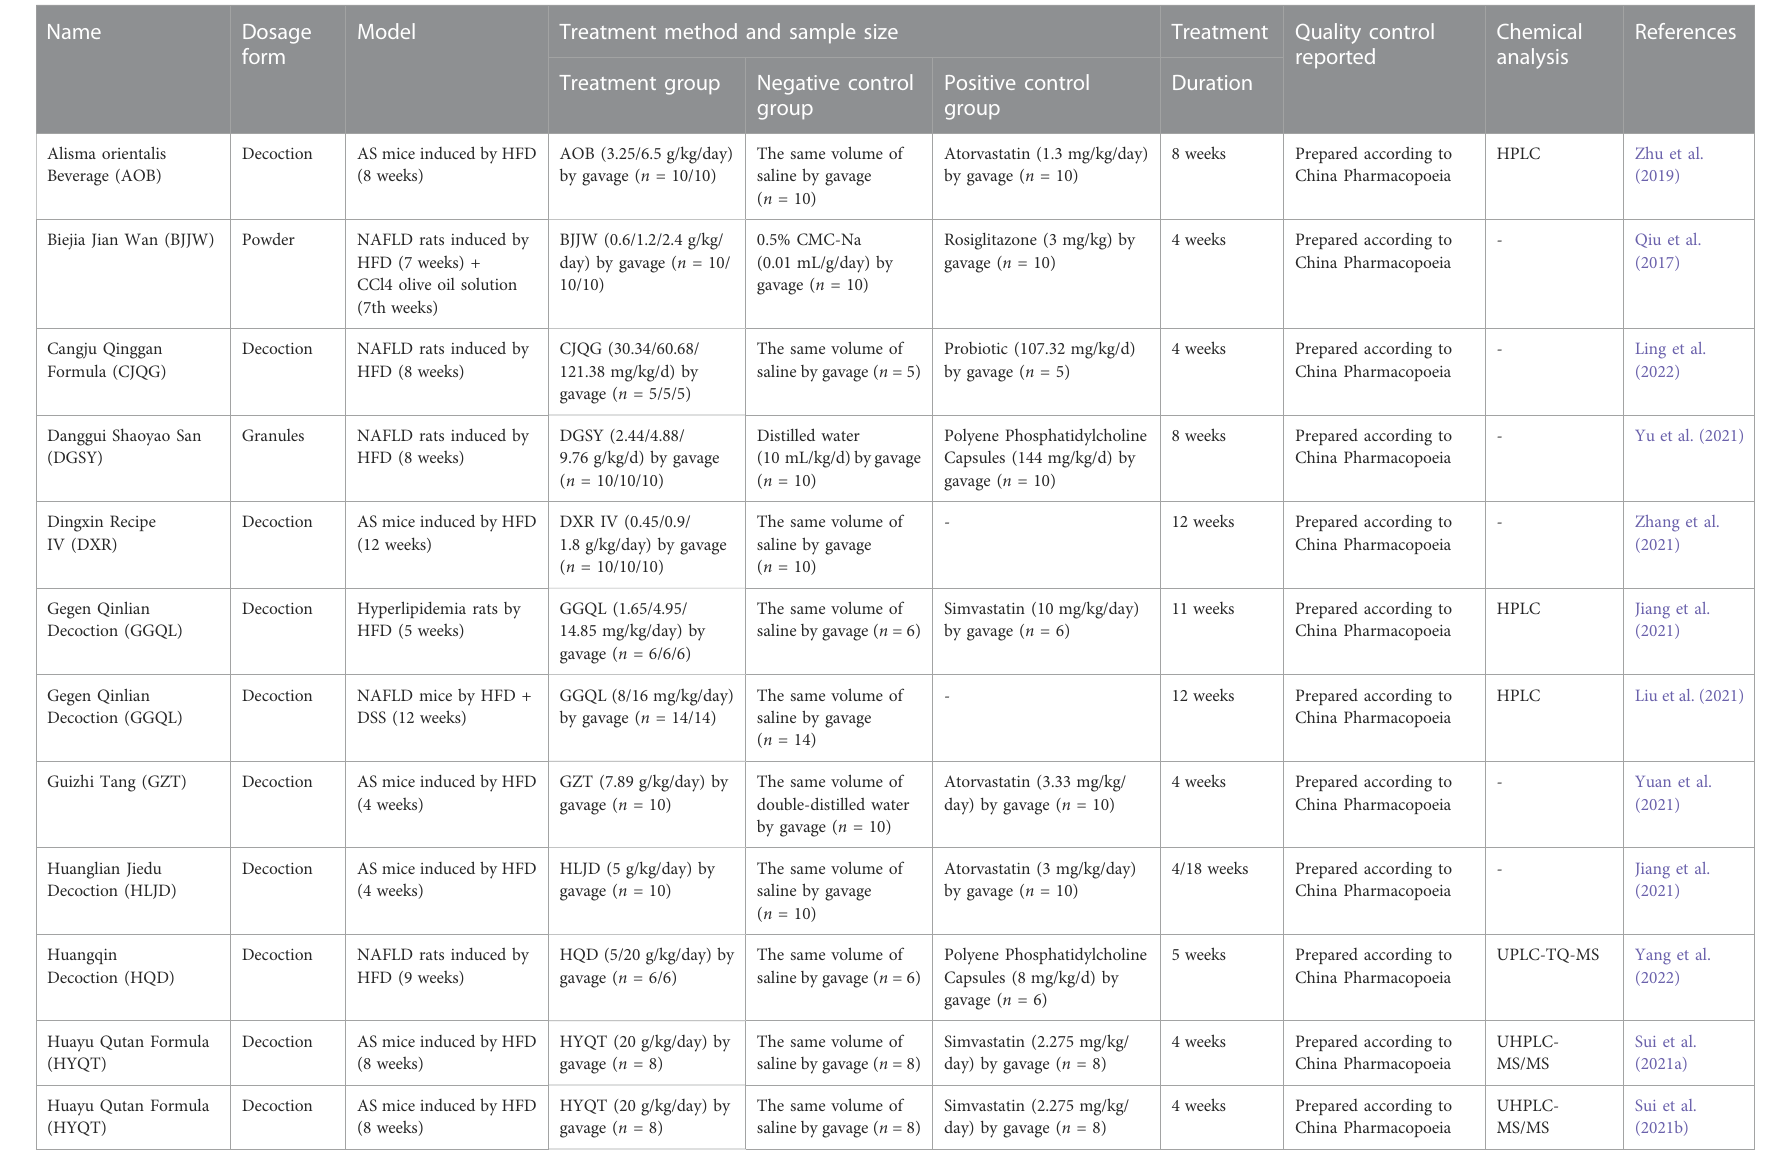
TABLE 3 Summary of TCM prescriptions used in animal